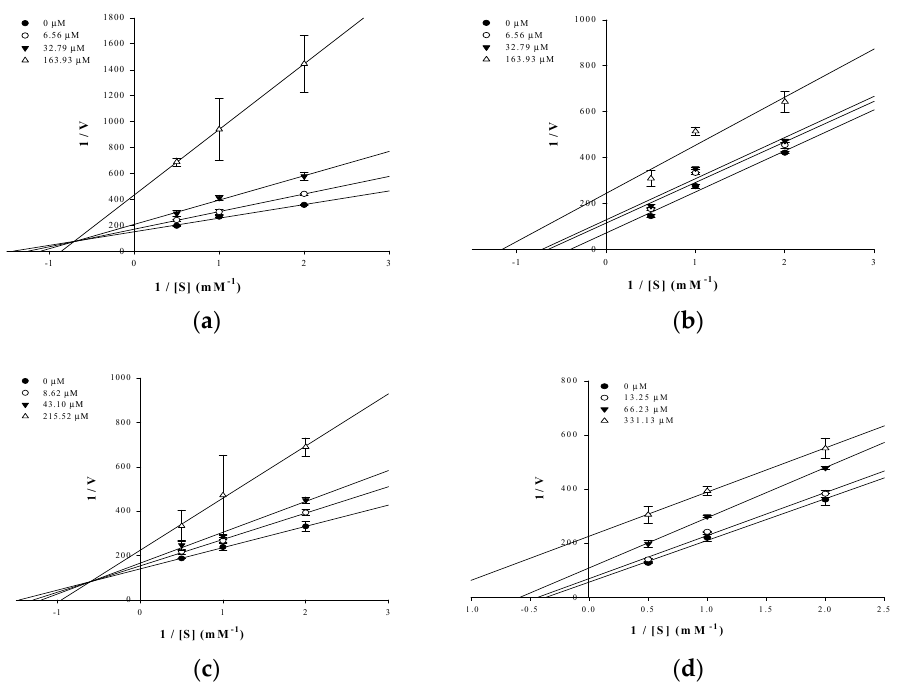
) and 2 mM ( (cid:72) ) for (cid:35)